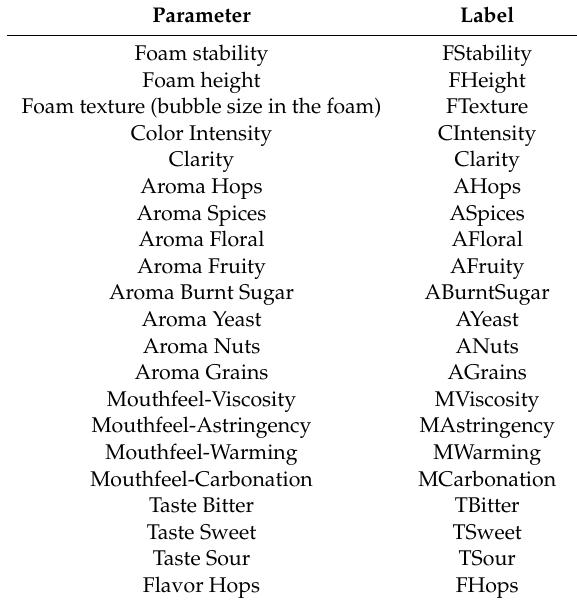
Table 3. Sensory attributes evaluated in the descriptive test and respective abbreviations